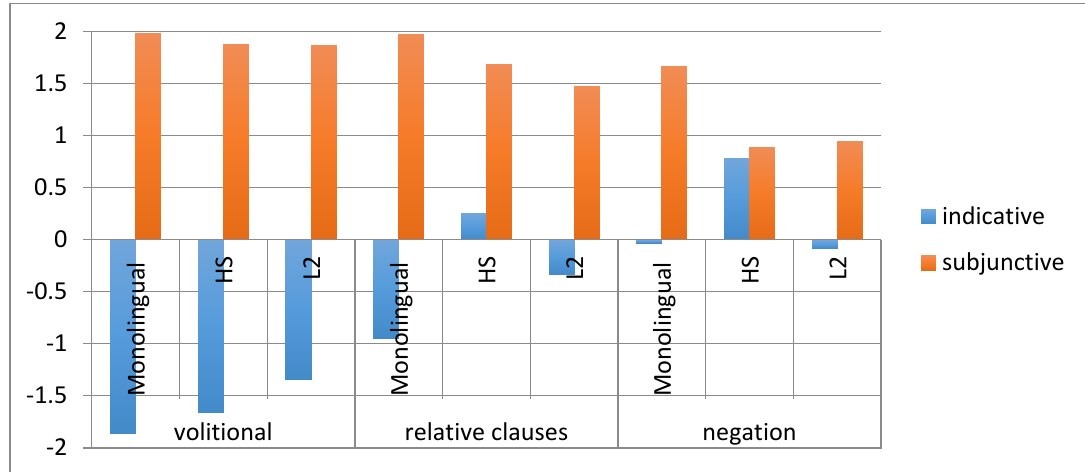
Figure 2. Mean ratings for the subjunctive (felicitous) and indicative (infelicitous) sentences per condition per group. HS: heritage speakers; L2: L2 speakers.